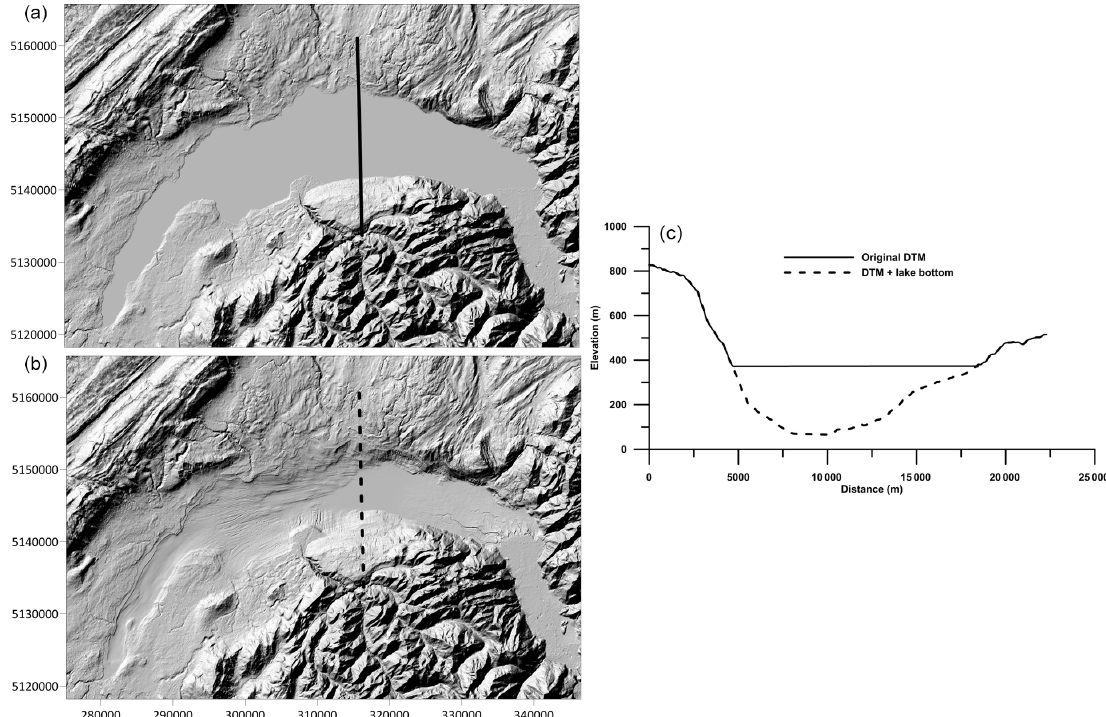
Figure 6. Examples of topography models used to calculate lake corrections (here, Lake Geneva, Switzerland). Top shaded relief (a) repre- sents the original DEM (MERIT) and the bottom one (b) the combination of DEM and lake bottom. The graph on the right (c) shows two profile lines crossing both models (north is to the right).